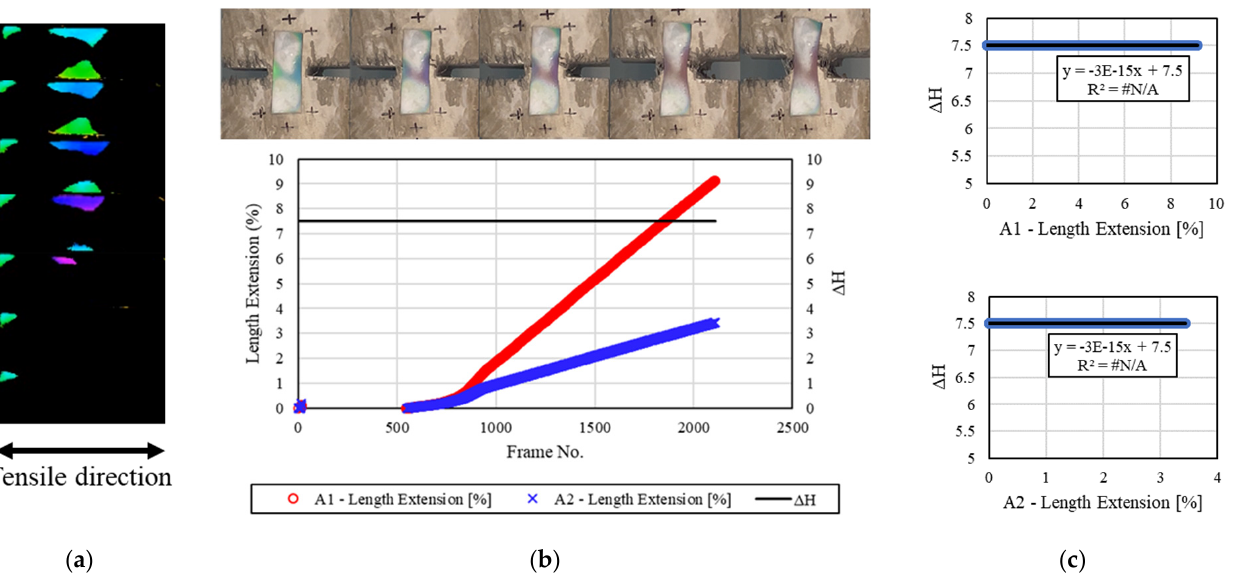
Figure 6. Results for the specimens after 0.5 h. ( a ) H-value image for discoloration color of mechanochromic sensor (90° rotation relative to tensile direction); ( b ) variations in strain and dH of A1 and A2 according to image frame. (The discoloration process of the mechanochromic sensor attached to the specimen and the tensile strain described in Figure 3 are shown.); ( c ) correlations of dH with A1 and A2.